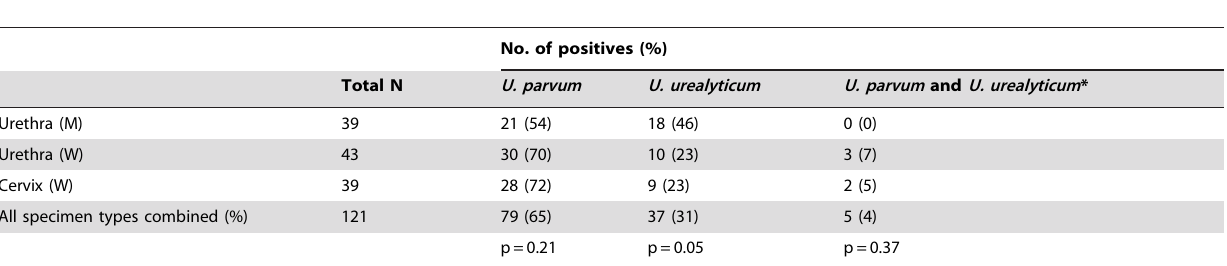
Table 6. Distribution of U. urealyticum and U. parvum by qPCR in culture positive male and female urethral samples and cervical